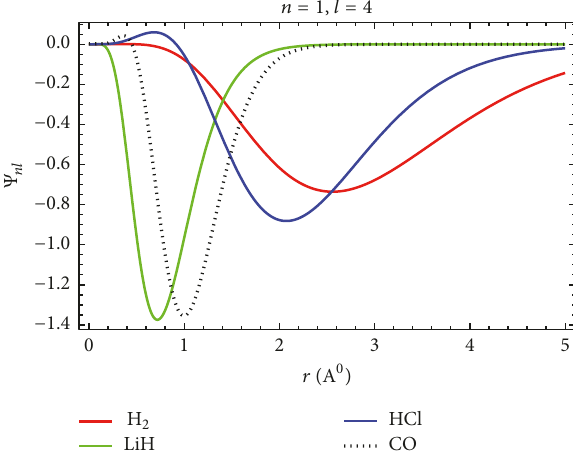
Figure 7: Wave function plot for the interaction potential with orbital angular quantum number 𝑙 = 4 .